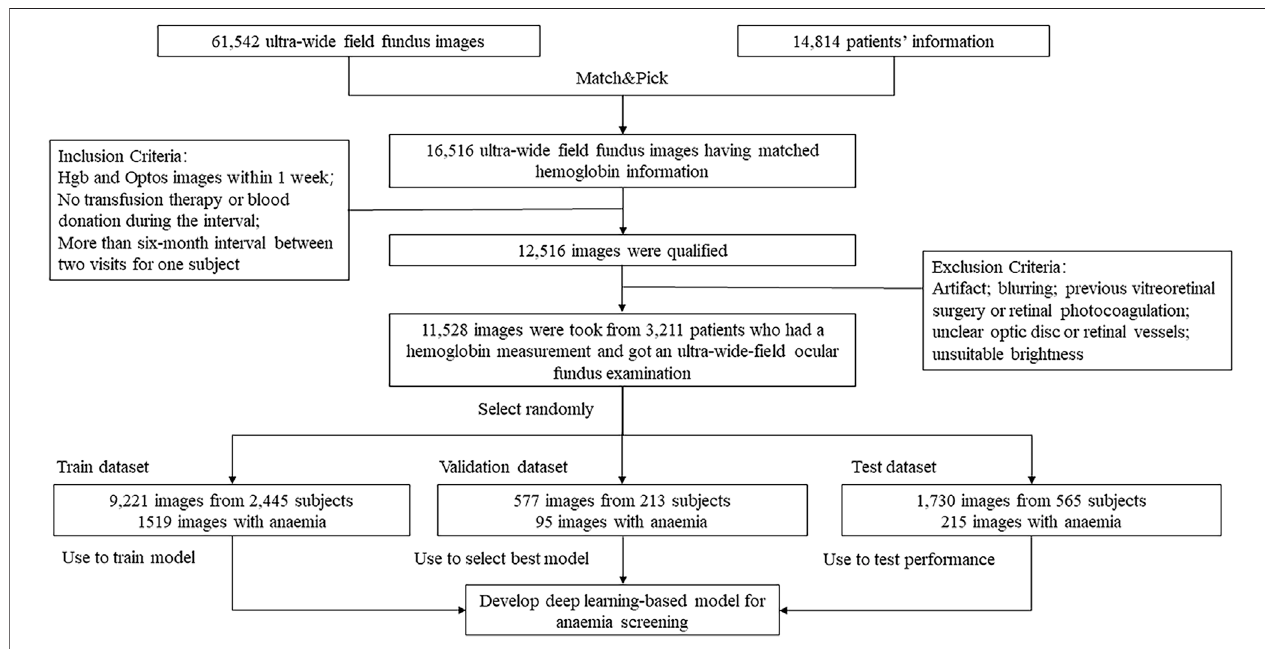
FIGURE 2 | Study pro fi le of dataset